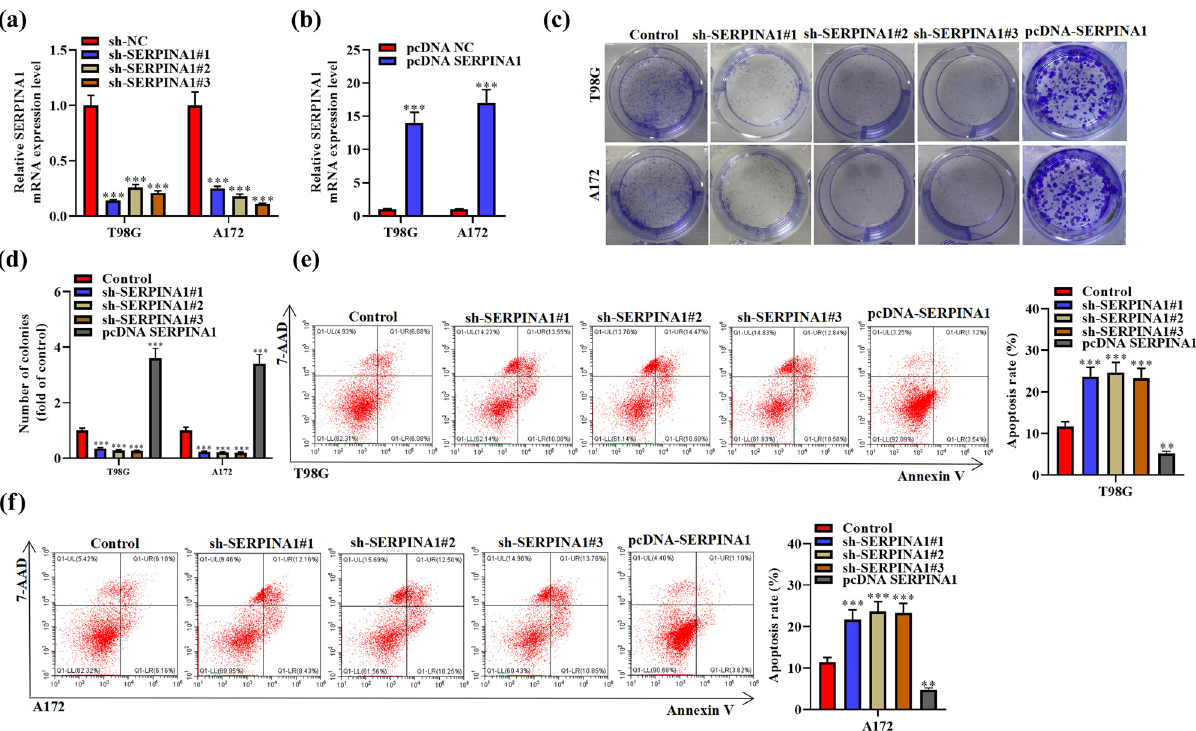
Figure 2: SERPINA1 a ff ects the proliferation and apoptosis of glioma cells. ( a ) Relative SERPINA1 mRNA expression level in T98G and A172 cells transfected with sh - SERPINA1, determined by qRT - PCR assay. One - way ANOVA was conducted. ( b ) Relative SERPINA1 mRNA expression level in T98G and A172 cells transfected with pcDNA SERPINA1 , determined by qRT - PCR assay. Student ’ s t test was conducted. ( c and d ) Colony formation assay and its quantitative diagram. One - way ANOVA was conducted. ( e ) Annexin V/7AAD double staining assay and apoptosis rate in T98G. One - way ANOVA was conducted. ( f ) Annexin V/7AAD double staining assay and apoptosis rate in A172. One - way ANOVA was conducted. Data are expressed as means ± SEM ( ** p < 0.01; *** p < 0.001, n = 3 )